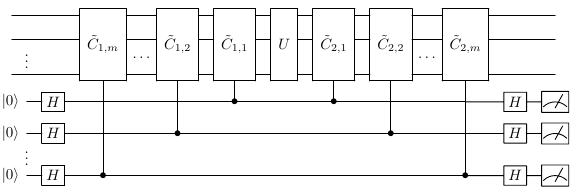
Figure 3. Multilayer scheme. There are n compute qubits, m layers, and m ancillas. The second index in the controlled unitaries represents the layer. Each layer uses one ancilla and two checks. The checks sandwich the input